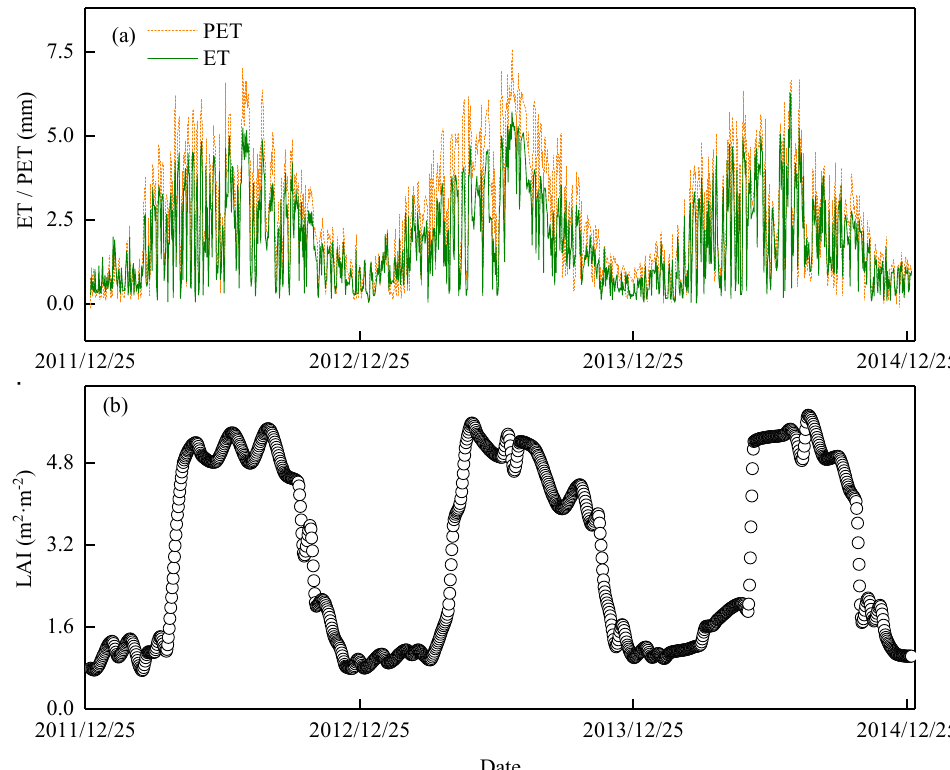
Figure 4. The dynamics of daily actual evapotranspiration (ET, mm), potential evapotranspiration (PET, mm) and leaf area index (LAI, m 2 · m − 2 ) in the Moso bamboo forest from 2012 to 2014. ( a ) Daily ET and PET, green line represents the ET and the orange, short dashed line represents the PET, respectively; ( b ) daily